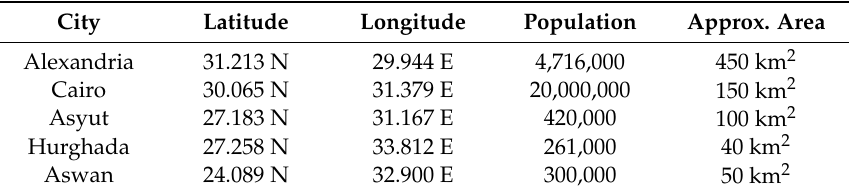
Table 1. Locations, estimated population, and area of selected cities. Figures of the populations are obtained from the website of the State Information Service (Egypt), http://www.sis.gov.eg/, with the population of Cairo including the entire metropolitan